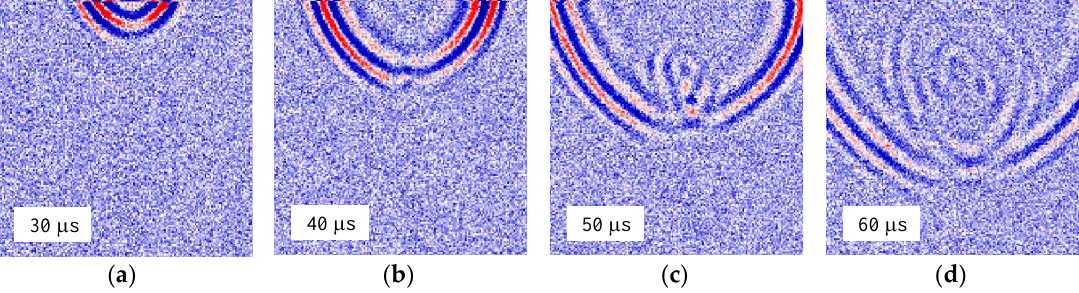
Figure 5. Lamb wave propagation in the impacted carbon fiber reinforced polymer (CFRP) quasi-isotropic laminate without signal averaging. ( a ) 30 µ s; ( b ) 40 µ s; ( c ) 50 µ s; ( d ) 60 µ s.